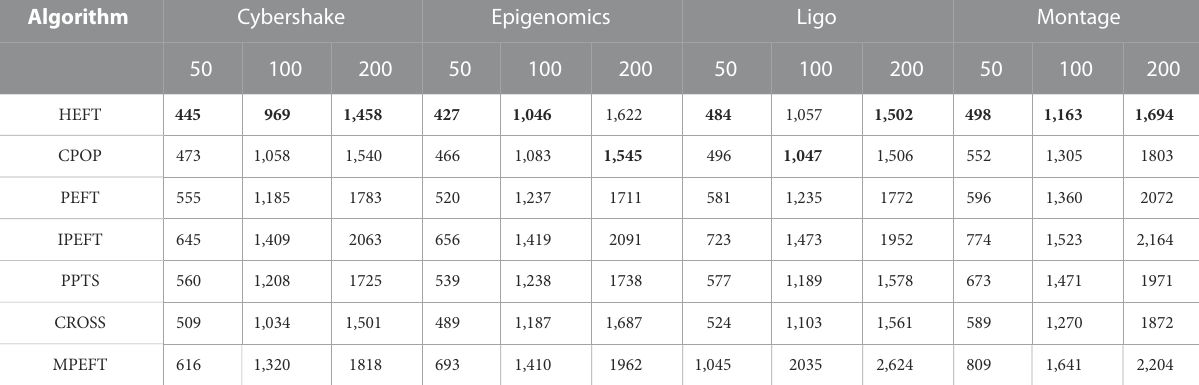
TABLE 8 Experimental Results in Terms of Average Running Time (in usec) on Real-World Work fl ows.